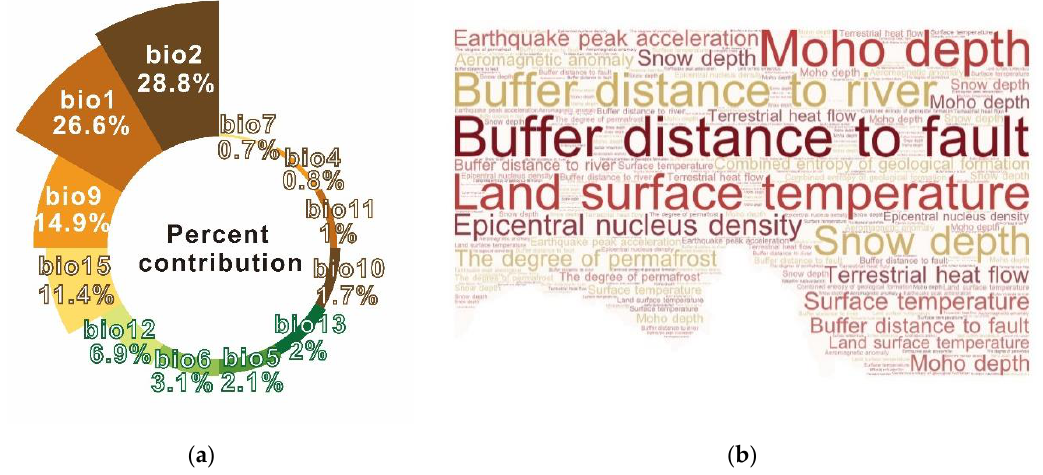
Figure 7. Environmental variable contributions to geothermal disaster risk: ( a ) Percentage contribution of environmental variables, ( b ) Word cloud of environmental variables.